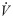
Metabolic responses during three exercise conditions.The lower arterial oxygen saturation (SpO2) during exercise at 40%peak in hypoxia (40%peak+HYP) did not affect total whole-body oxygen consumption (V˙O2) due to a compensatory increase in ventilation (VE). However, as a consequence of altered metabolism, lactate and RER were significantly increased during 40%peak+HYP. IAT = individual anaerobic threshold; *: P < 0.05; **: P < 0.01; ***: P < 0.001.